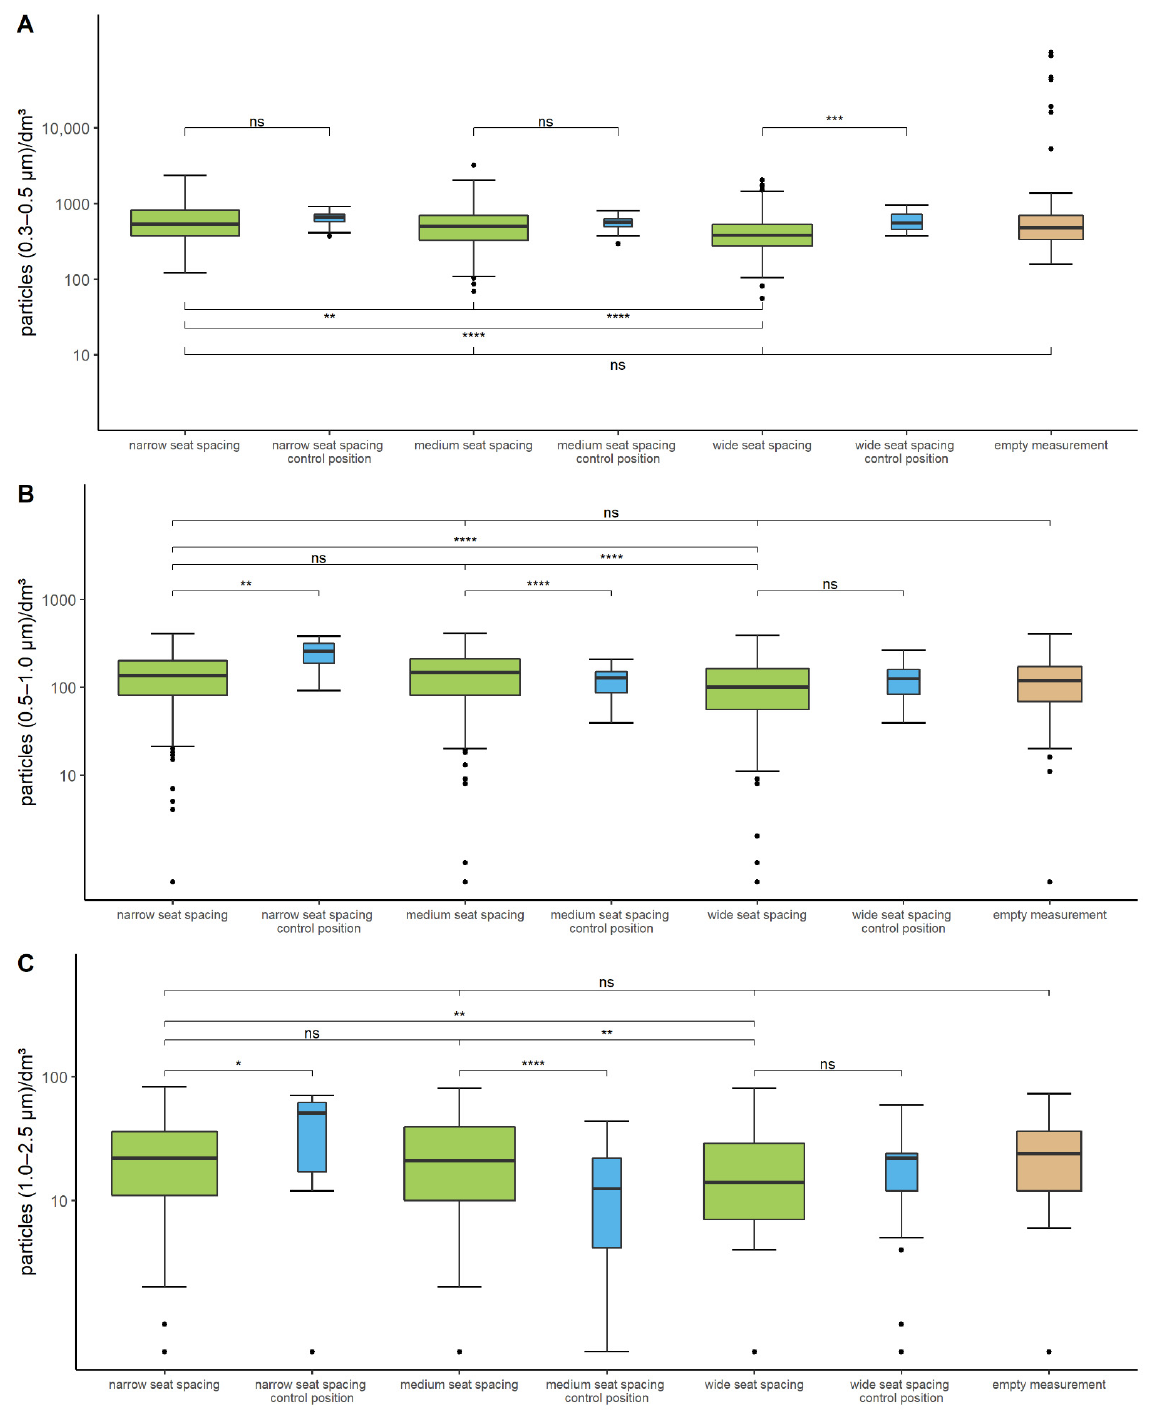
Figure 2. Particle count in indoor air during music making. Shown is the number of particles in indoor air for particle sizes 0.3–0.5 µm ( A ), 0.5–1.0 µm ( B ), and 1.0–2.5 µm ( C ). The detection limit for all particle sizes is 1 particle/dm 3 . The width of the boxplots represents the number of contained data. The green colored boxplots display the number of particles during music making in the different setups of seating (narrow, medium, wide) on stage. Blue colored boxplots represent the number of particles at the control position on stage as well as orange-colored boxplots the empty measurement. Brackets display the results of the statistical analysis. The characters “ns”, “*”, “**”, “***” and “****” represent the adjusted p -value “not significant”, “<0.01”, “<0.001”, “<1 × 10 − 4 ”, “<1 × 10 − 5 ”,